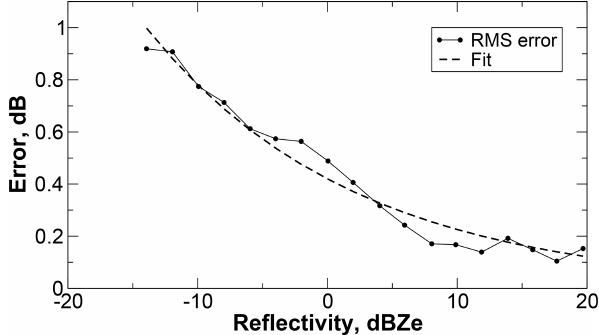
Figure 3. Estimated measurement uncertainty, based on 1 standard deviation of noise for the CloudSat CPR.